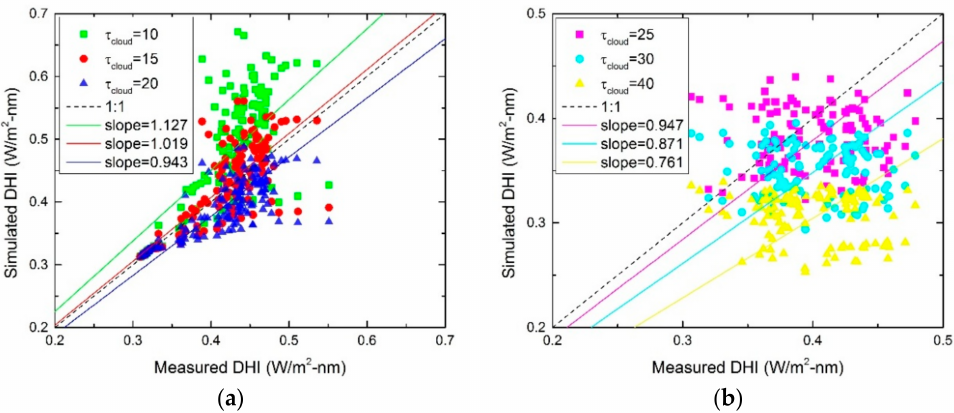
Figure 5. The linear fitting results of scatter points for selecting the appropriate cloud optical depth: ( a ) the sun is not occluded; and ( b ) the sun is